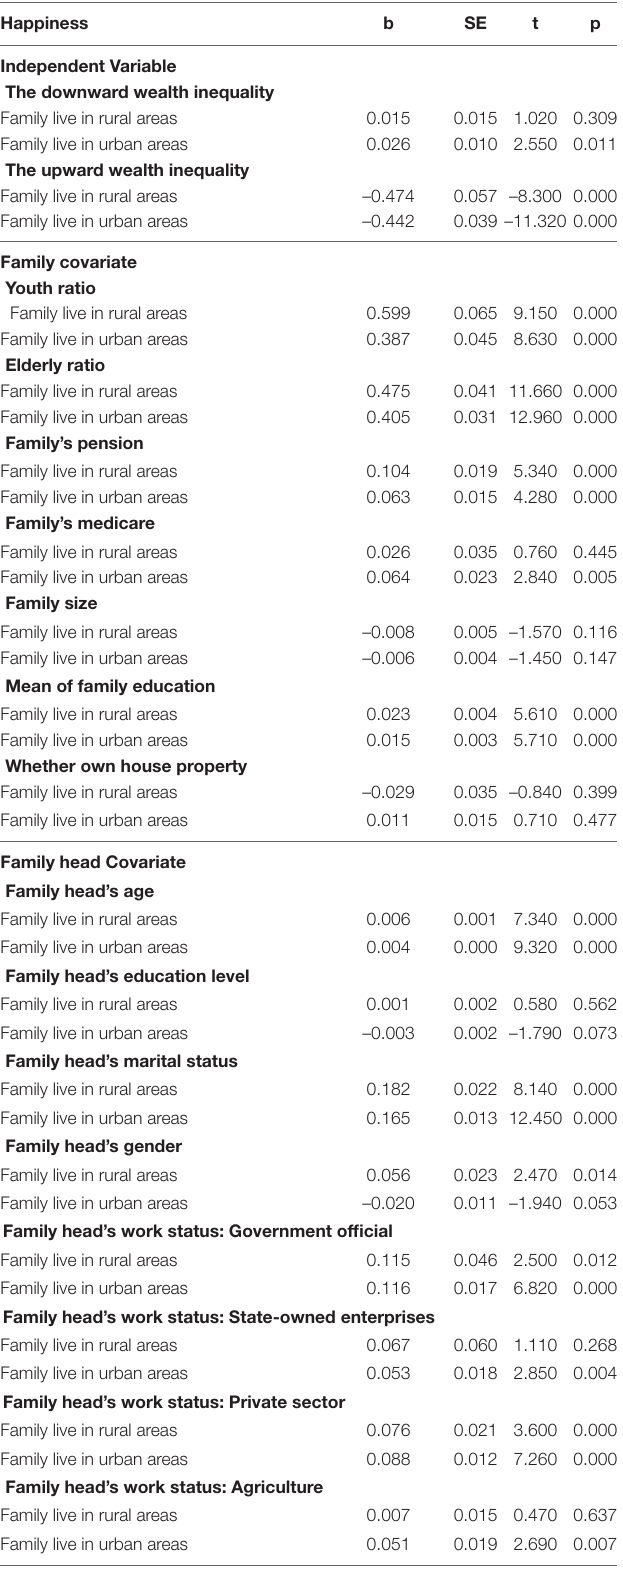
TABLE 4 | Regression on happiness with the upward wealth inequality and the downward wealth inequality for stratified sample by residence. Happiness b SE t